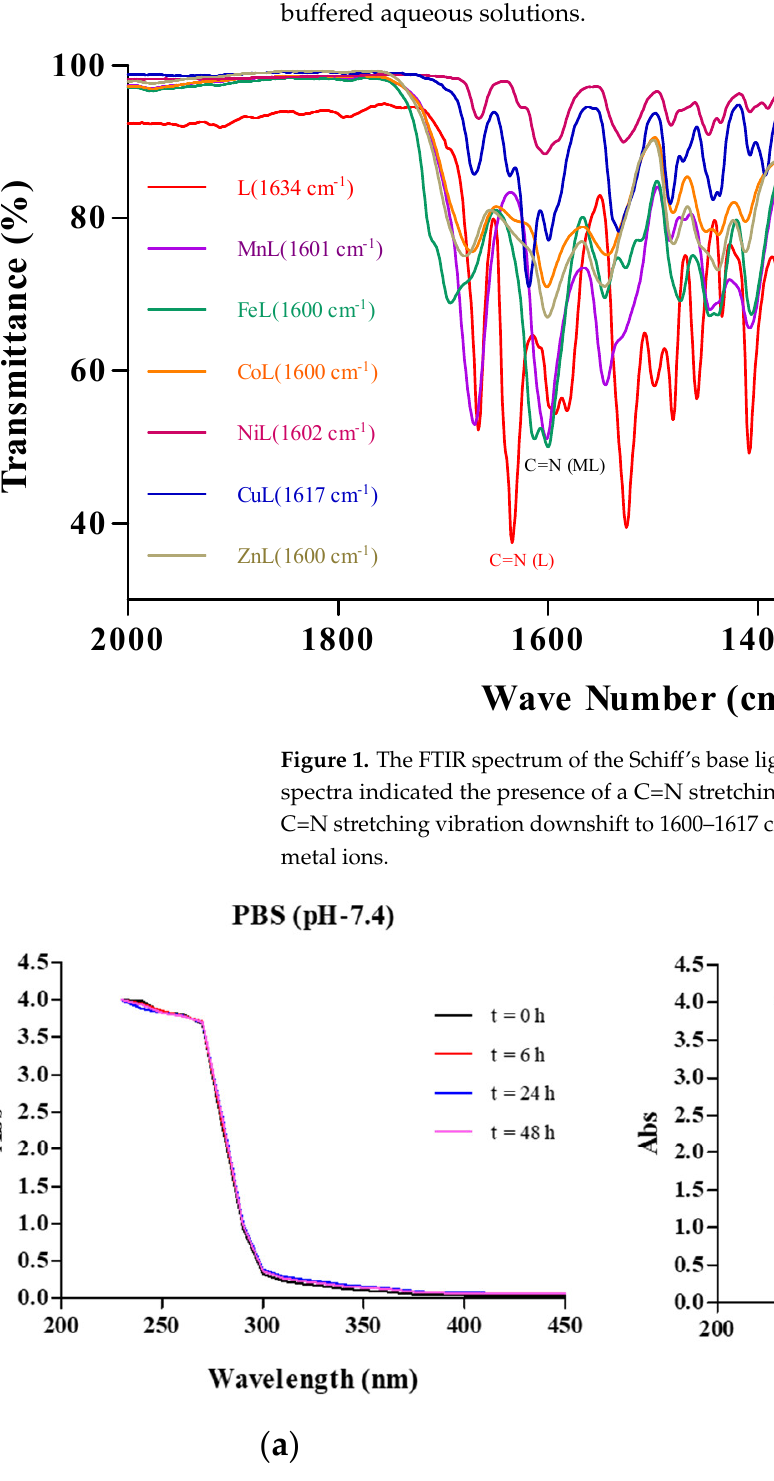
Figure 2. Time-dependent UV − Vis spectrum of the MnL complex in ( a ) PBS, and ( b ) DMEM cell culture medium at pH 7.4 and 25 ◦ C in the 200 − 450 nm